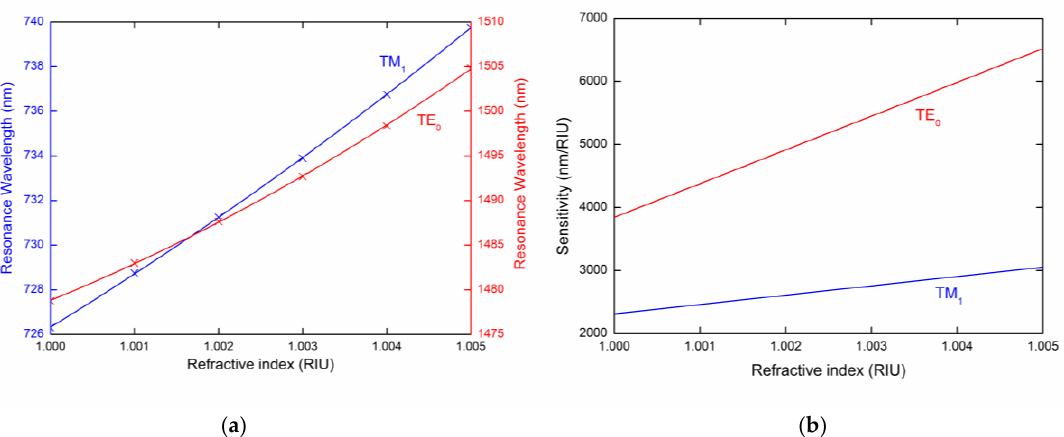
Figure 4. ( a ) Resonance wavelength and ( b ) sensitivity of the TM 1 and TE 0 modes as a function of the refractive index of the external